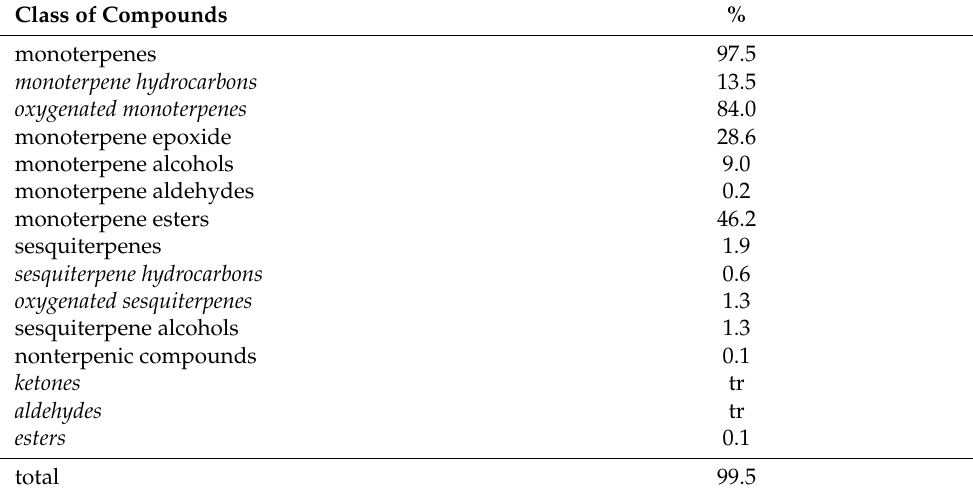
Table 4. The total amounts of volatiles, presented in percentages for each class of